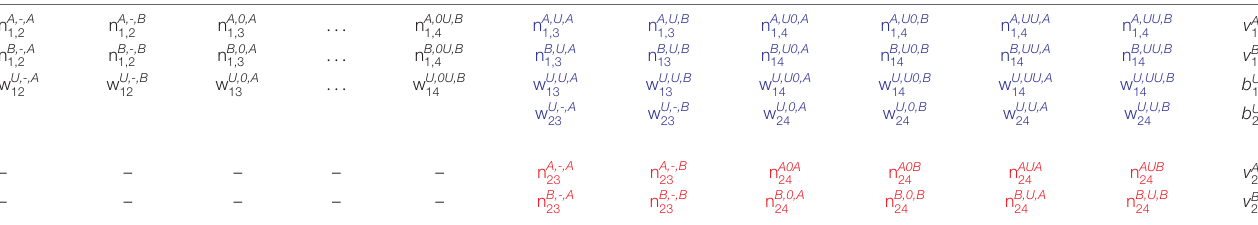
TABLE 2 | The sufficient statistics for multinomial distributions corresponding to individuals released before or at i = 2 in an capture-recapture experiment with four occasions where individuals can be in any of two live states. n A,-,A